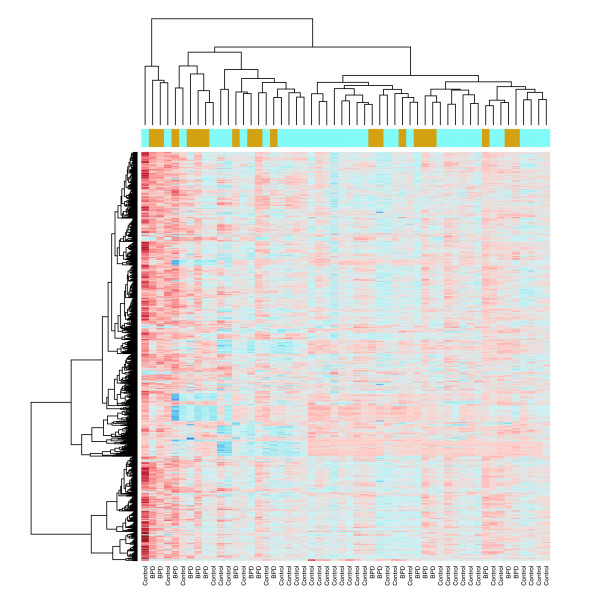
Unsupervised clustering based on Euclidean distance in expression between samples. Each row corresponds to a gene and each column (labeled at the bottom) corresponds to an infant who subsequently developed bronchopulmonary dysplasia (BPD) or a control infant.